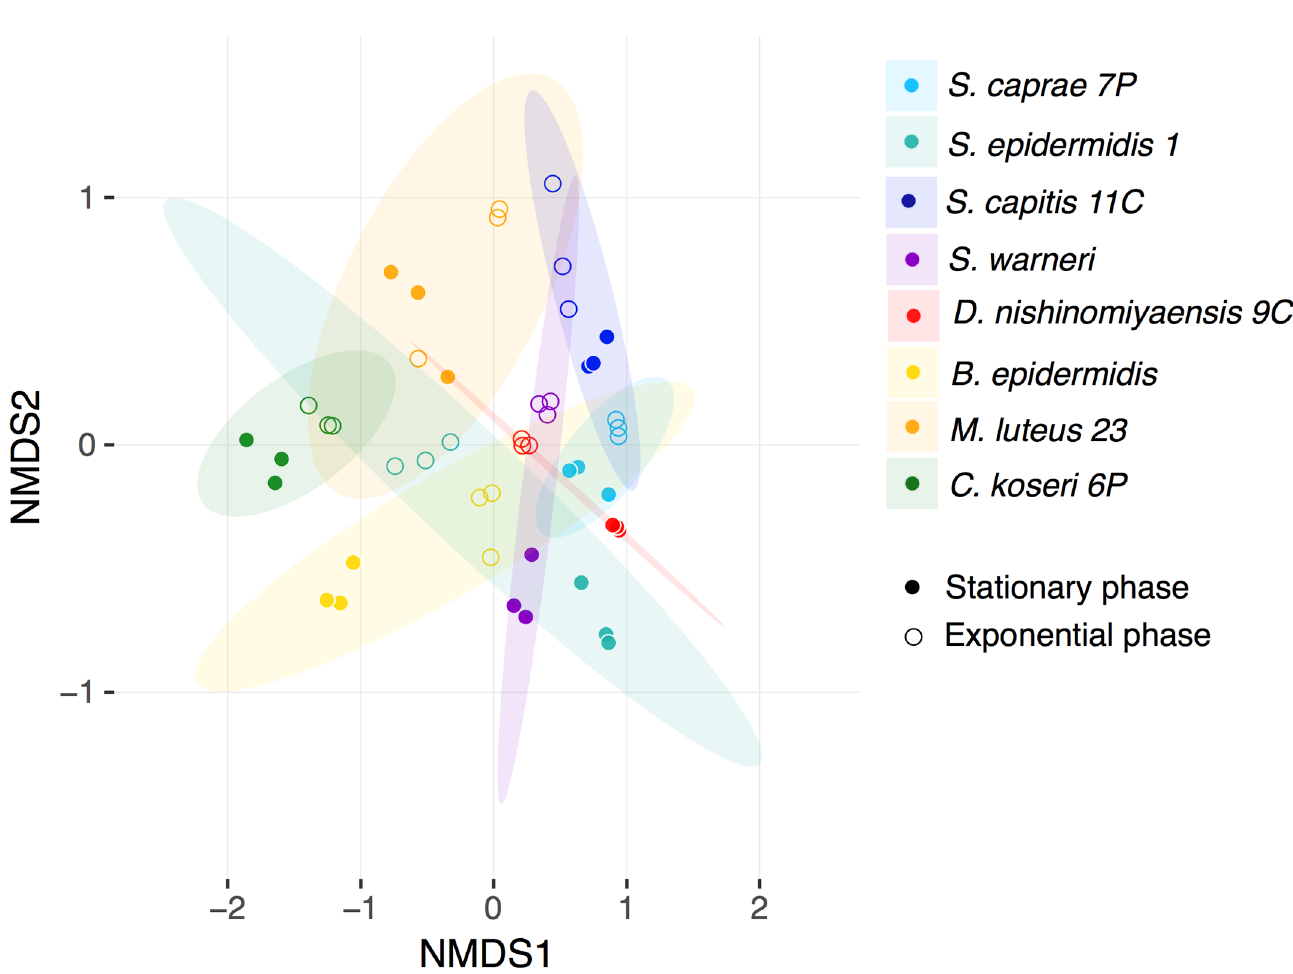
Fig 3. NMDS of VOC profiles from eight bacterial species isolated from human facial skin and cultured in vitro to two different growth phases. The analysis uses Bray-Curtis distances as a measure of dissimilarity. Stress value = 0.1776. Ellipses for each bacterial species ( S . caprae 7P, S . epidermidis 1, S . capitis 11C, S . warneri , D . nishinomiyaensis 9C, B . epidermidis , M . luteus 23, and C . koseri 6P) describe a confidence interval of 95% using t